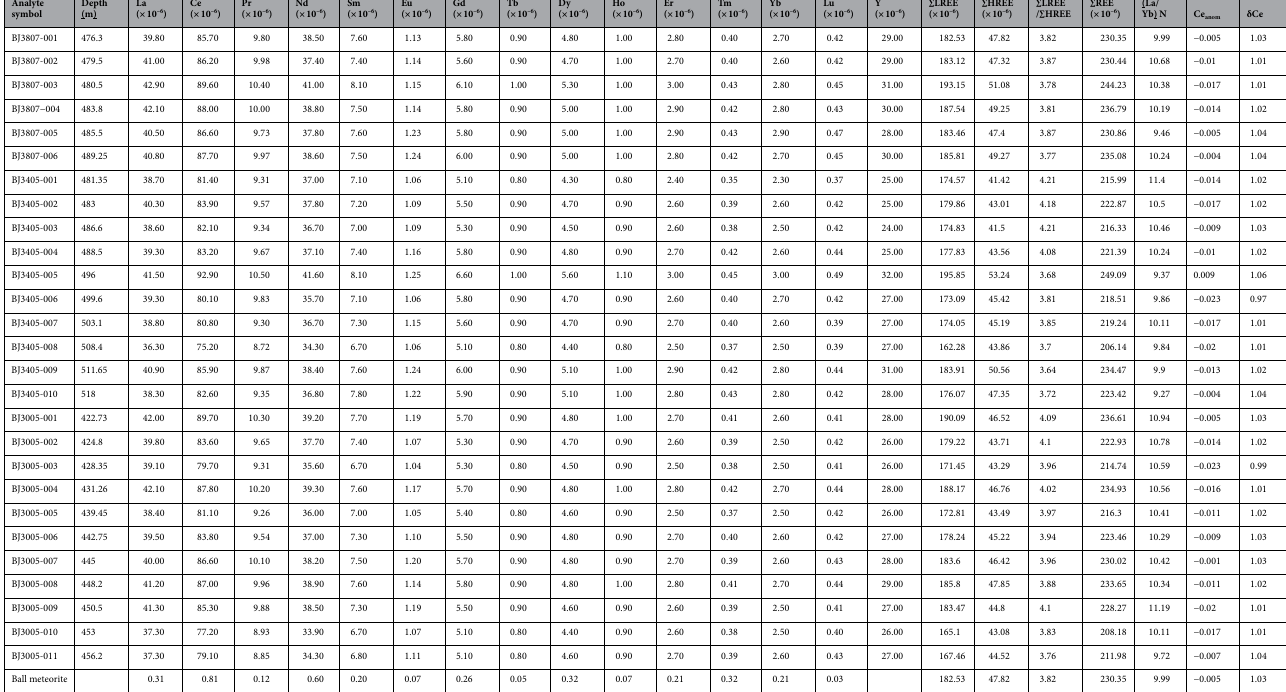
Table 2. Contents of major elements of oil shale in Bayanjargalan Basi n. ∑LREE is the content of light rare earth elements; ∑HREE is the content of heavy rare earth elements; ∑REE is the content of rare earth elements; ∑LREE/∑HREE is the ratio of the content of light rare earth elements to that of heavy rare earth elements; N represents the chondrite-normalized value; (La/Yb)N represents the ratio of La chondrite-normalized value to Yb chondrite-normalized value; δEu and δCe represent the anomalies for Eu and Ce; EuN, SmN, and GdN represent the measured chondrite-normalized values; δCe = CeN/(LaN × PrN)1/2; CeN, LaN, and PrN represent the measured chondrite-normalized values; Ceanom = lg(3CeN/(2LaN + NdN)).